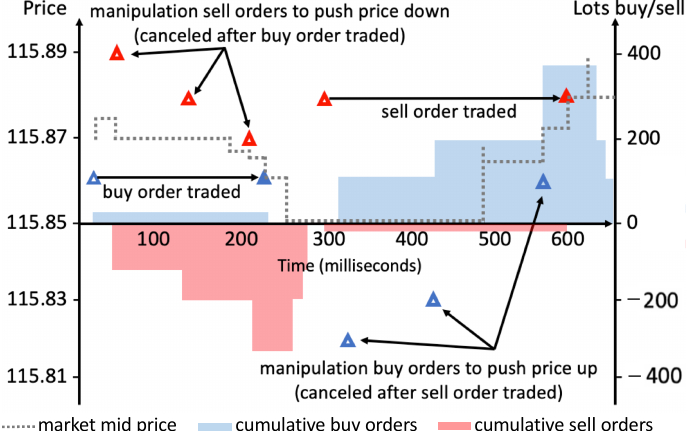
Figure 1. Example of alleged spoofing. Source: UK Financial Conduct Authority Final Notice 2013. A series of large out-of-the money manipulation sell orders (red triangles) are first placed to drive the price down and make the buy order accepted (the filled blue triangle). These sell orders are immediately replaced with large buy ones (blue triangles) to push the price up and profit from the sale at a higher price (the filled red